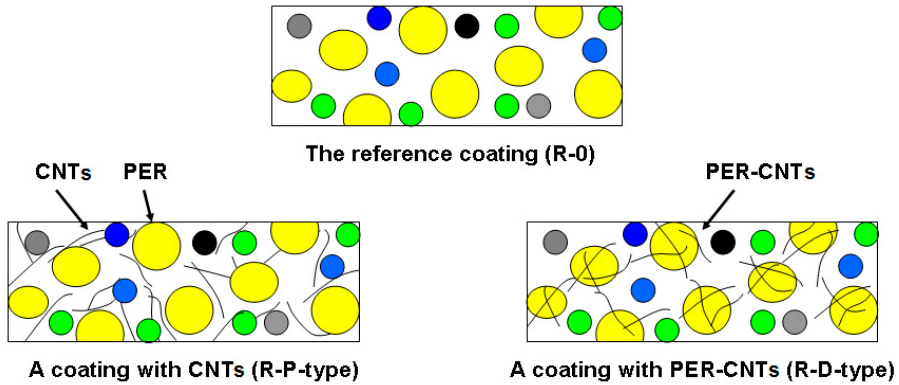
Figure 1. Schemes of structures of the tested intumescent coatings (i.e., the reference sample and the samples with CNTs or PER-CNTs solid dispersions).